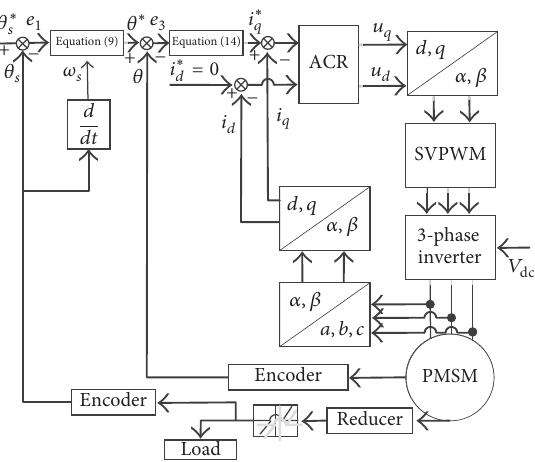
Figure 2: Control block diagram of the